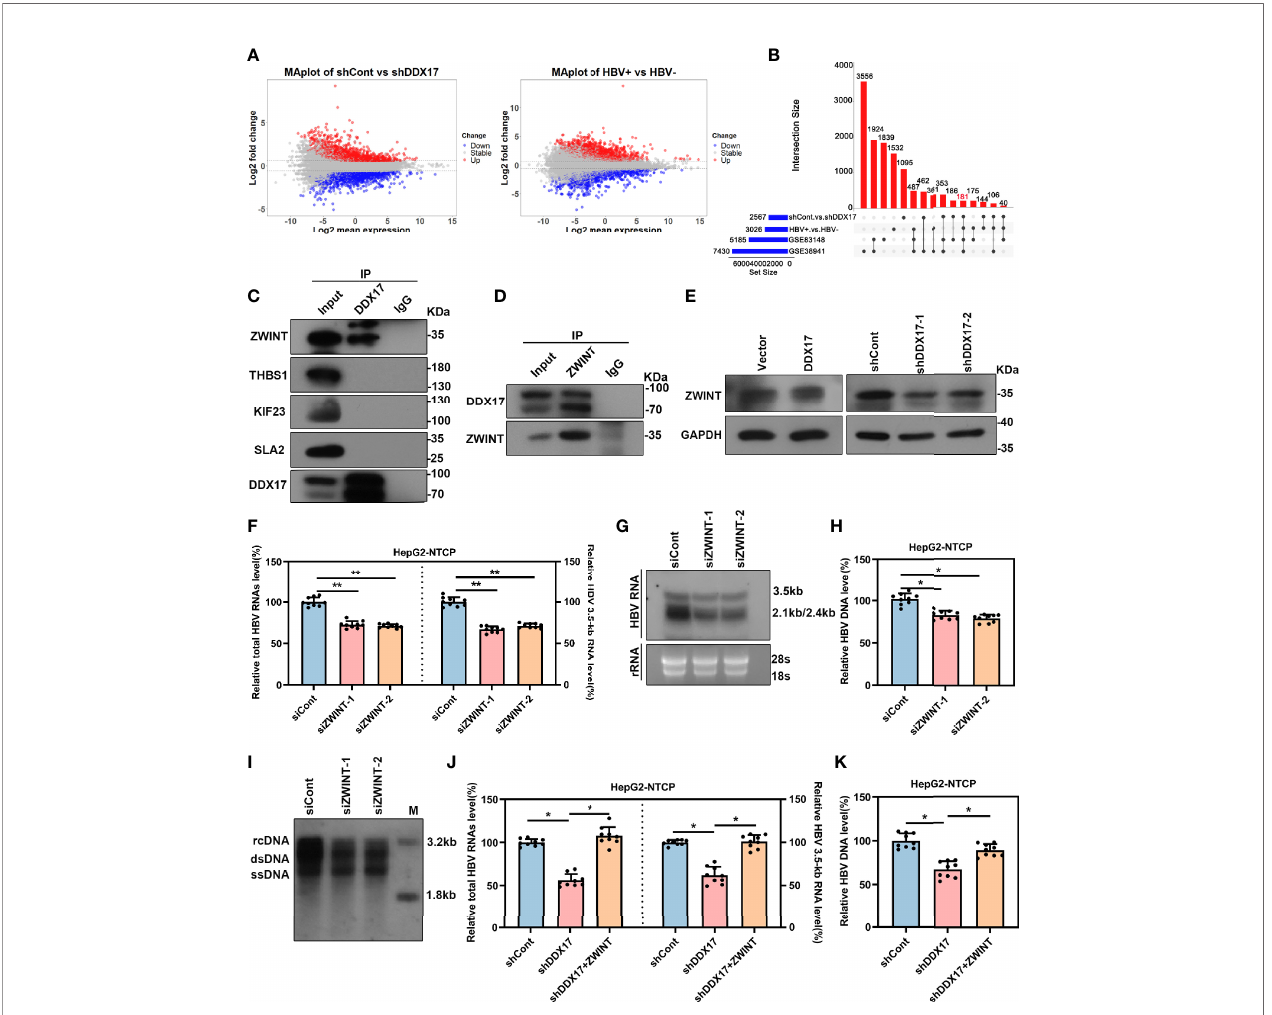
FIGURE 5 | DDX17 promotes HBV transcription and replication by upregulating ZWINT. (A) Volcano plot for potential DEGs in two RNA-seq datasets (HBV- infected HepG2-NTCP cells with or without DDX17 knockout; liver tissue from HCC patients with or without HBV infection) (log2FC>0.585, p value<0.05). (B) The Venn diagram shows 181 co-expressed genes were identi fi ed among GSE83148, GSE38941 and two RNA-seq data. (C) The co-immunoprecitation assay (Co-IP) analysis showing the interactions between DDX17 and its candidate interacting proteins. (D) Co-IP assay was performed with anti-DDX17 antibody in HBV-infected HepG2-NTCP cells transfected plasmid expressing ZWINT. (E) DDX17 regulated ZWINT protein expression in HBV-infected HepG2-NTCP cells measured by western blot assay. GAPDH was used as an internal quantitative control. (F, G) Real-time PCR and Northern blot assay were used to analysis the effect of ZWINT knockdown on HBV RNAs in HBV-infected HepG2-NTCP cells. (H, I) Real-time PCR and Southern blot assay were used to analysis the effect of ZWINT knockdown on HBV DNA replicative intermediates in HBV-infected HepG2-NTCP cells. (J, K) Reintroduction of ZWINT antagonized the effect of DDX17 knockdown on HBV transcription and replication. Total HBV RNAs, 3.5-kb RNA (J) and HBV DNA replicative intermediates (K) were extracted and examined by real-time PCR. *P < 0.05, **P <